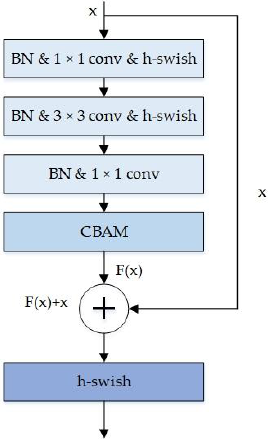
Figure 4. C-Bottleneck: residual block after embedding CBAM.